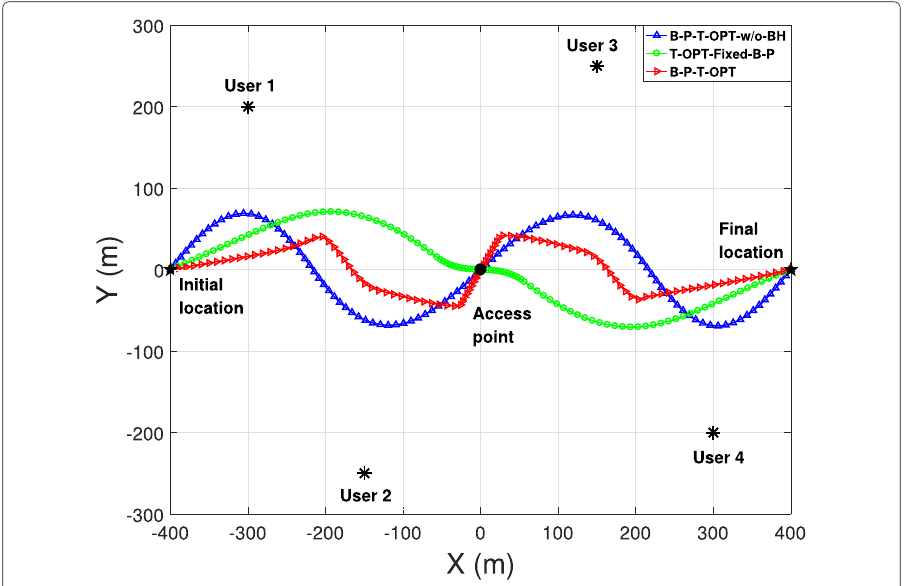
Fig. 2 UAV trajectories obtained by different schemes when T = 50